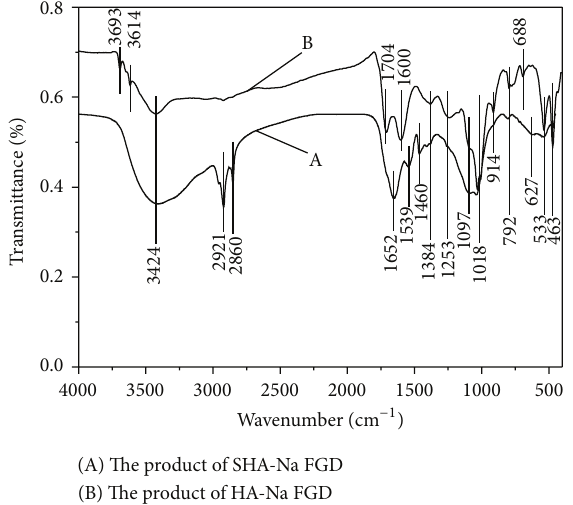
Figure 7: FTIR spectra of desulfurization product (SO 2 , 2500 ppm; gas flow, 0.12m 3 /h; absorption solution, 100mL; O 2 , 5vol%; 25 ∘